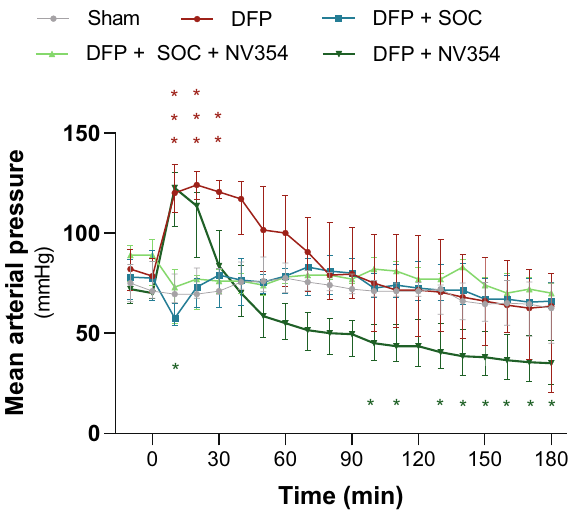
Figure 2. Mean arterial pressure changes. Mean arterial pressure was measured over time in sham animals (Sham) and animals exposed to diisopropylfluorophosphate alone (DFP) with and without standard of care (SOC) treatment and/or the cell-permeable succinate prodrug NV354 (NV354). Time course analysis was performed using two-way ANOVA with Geisser-Greenhouse correction and Dunnett’s multiple comparison test with comparison to baseline (t 0min ). *p < 0.05; **p < 0.01 and p*** < 0.001 indicate significant difference. n = 6–7 per